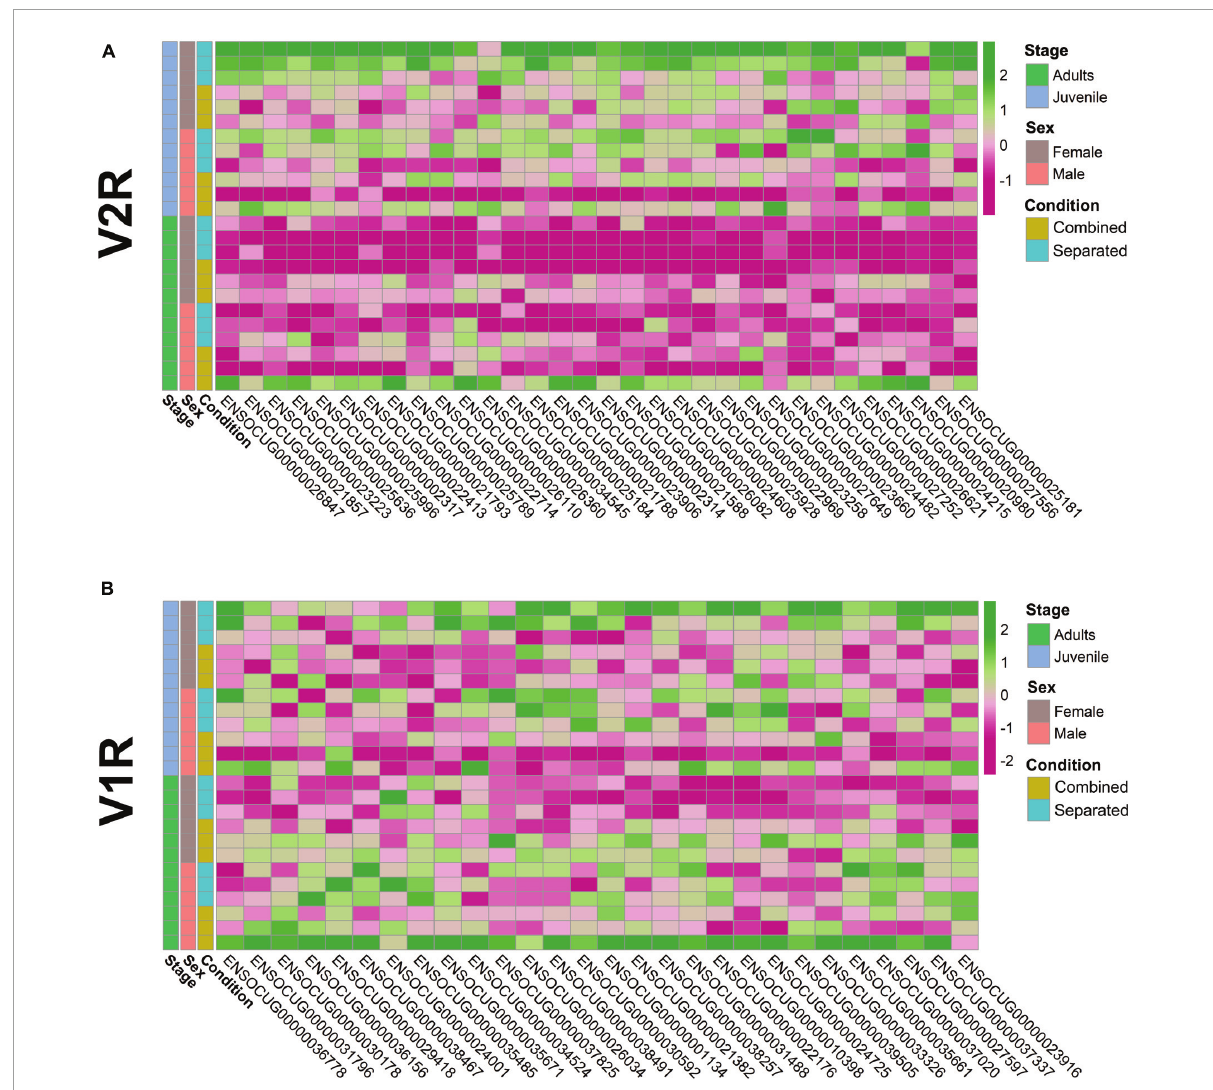
FIGURE2 Heatmaps of differentially expressed (A) V2Rs ( p -value < 0.05) and (B) V1Rs ( p <